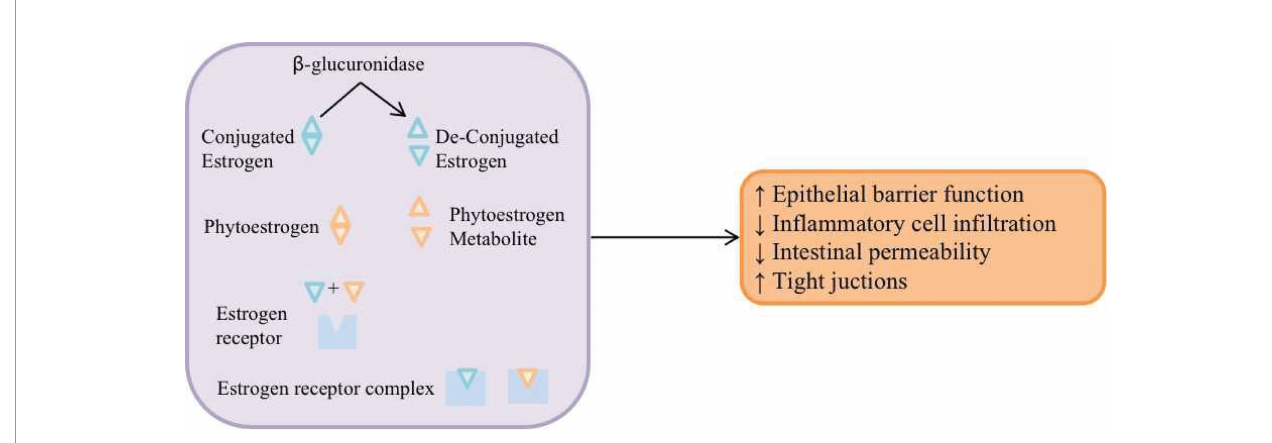
FIGURE 1 | The gut microbial community regulates estrogens through secretion of b -glucuronidase. b -glucuronidase de-conjugates estrogen to enable the binding to estrogen receptors, and then, regulates the intestinal function and micro-environment and increase the breast